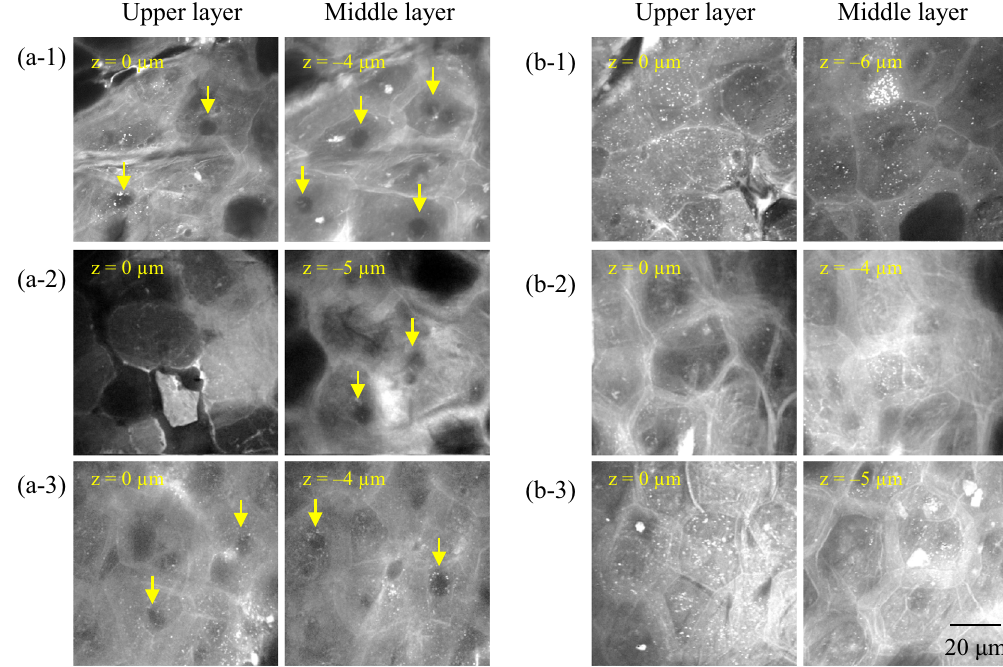
Figure 5. Holes in the stratum corneum. Optical cross-section images at 2930 cm − 1 mainly reflect proteins in the stratum corneum. Yellow arrows indicate some of the holes. ( a 1–3) Images of abdominal sites of 33-, 70-, and 74-year-old Caucasian females, respectively, suggest that keratin embedding was not completed after enucleation. ( b 1–3) Images of abdominal skin sites of 39-, 49-, and 56-year-old Caucasian females, respectively, showing no holes.